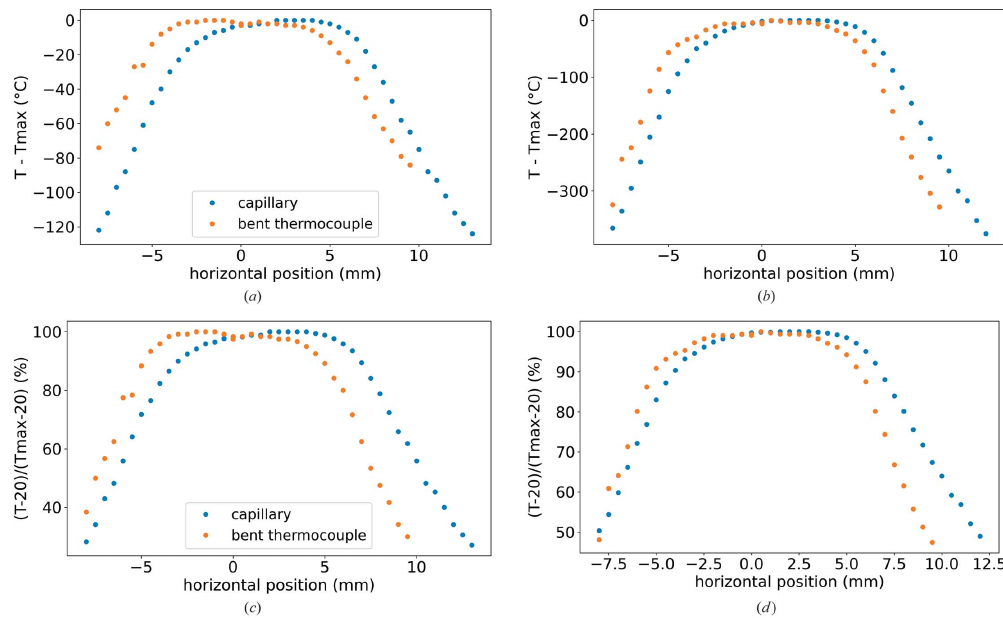
Figure 5 Axial temperature subtracted by maximum temperature measured at ( a ) 200 (cid:2) C and ( b ) 800 (cid:2) C, and relative temperatures at ( c ) 200 (cid:2) C and ( d ) 800 (cid:2) C measured using a thermocouple in two configurations: one in which the thermocouple was placed inside a capillary, and the other where most of the thermocouple was outside the heater with the tip bent into the heater’s mouth.